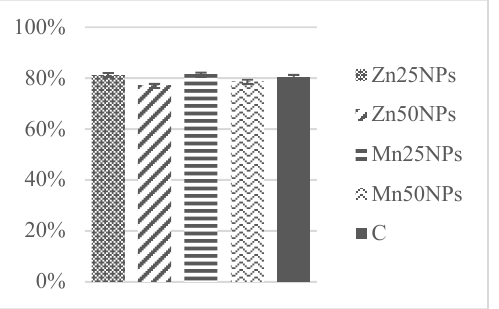
Figure 1. Percentage of sperm with intact plasma membrane (%) in samples stored for 2 h with or without (C) the addition of ZnNPs and MnNPs.